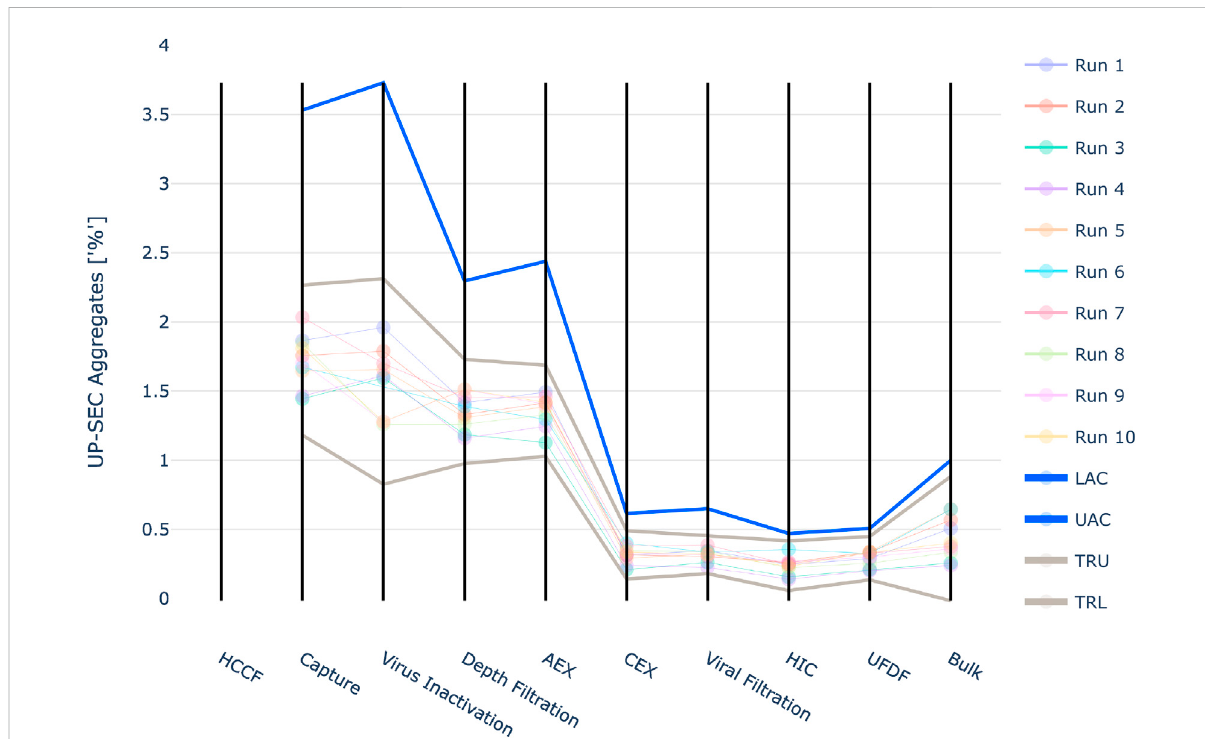
FIGURE 10 Graphical representation of the intermediate acceptance criteria (blue line) across the entire downstream process for the response UP-SEC Aggregates. Available large scale, manufacturing data per batch (circles) and three standard deviation derived ranges (grey lines) are given as well. The shown iACs at DS are the DS speci fi cation